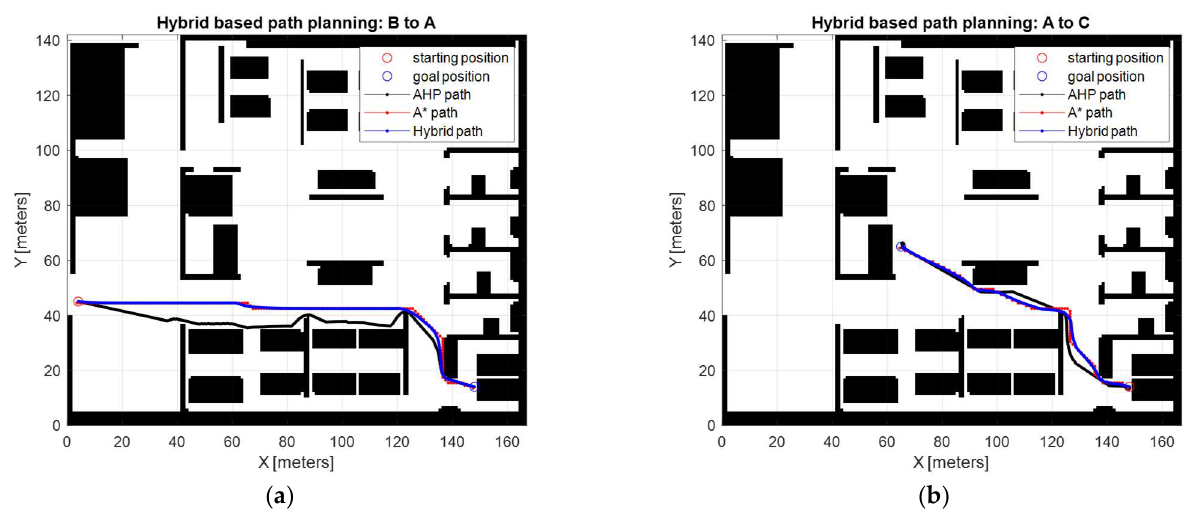
Figure 18. Scenario-based path planning: ( a ) Path from ⓑ to ⓐ ; ( b ) path from ⓐ to ⓒ .